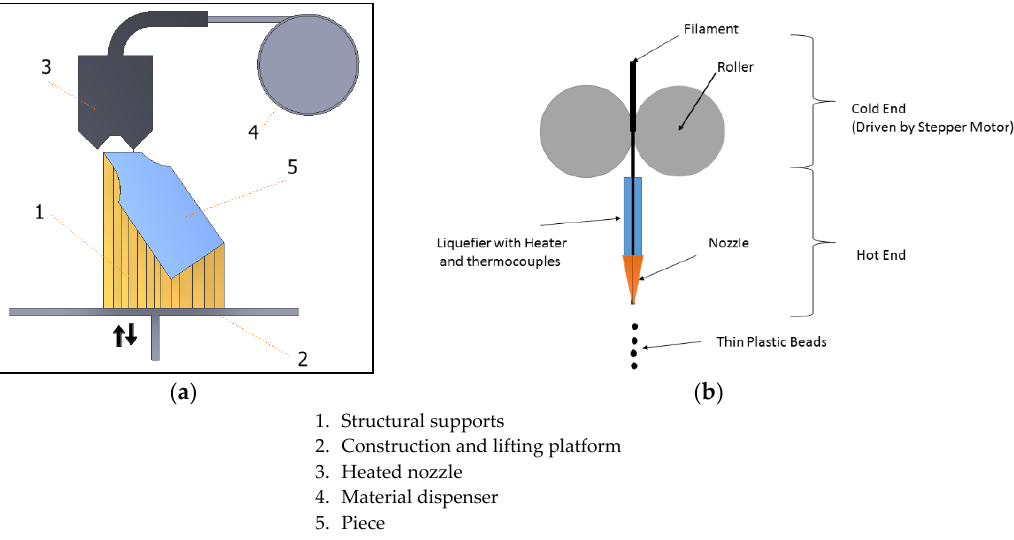
Figure 1. ( a ) A sketch of the material extrusion process; ( b ) An extruder sketch in an FDM/FFF (Fused Deposition Modelling/ Fused Filament Fabrication) process. Deposition Modelling/ Fused Filament Fabrication)